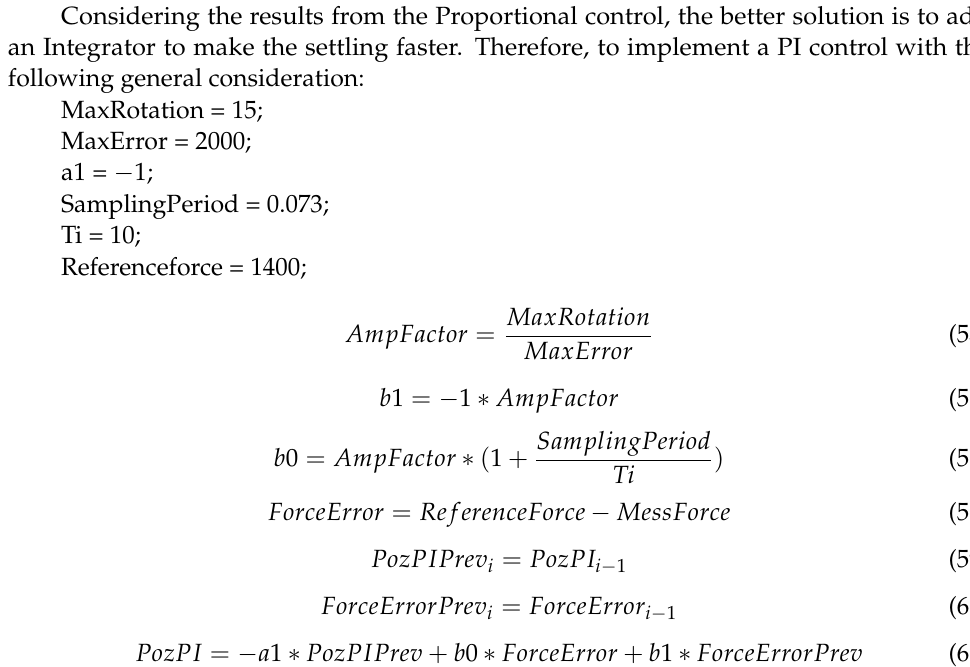
Figure 16. Bipolar control system.